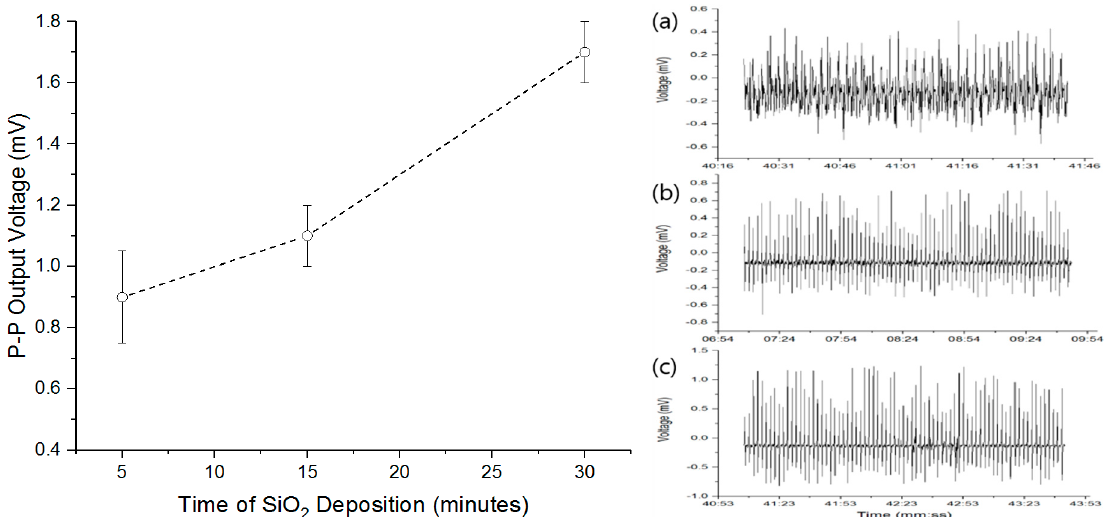
Figure 5. ( Left ) Peak to peak (P–P) output voltages of three SZS ‐ MGs as a function of the SiO 2 deposition time. (Average deposition rate of SiO 2 = 7.05 nm/min, ZnO = 4.55 nm/min at 200 W deposition power). ( Right ) Output voltage variations of the SZS ‐ MGs with SiO 2 thin films deposited for ( a ) 5 min, ( b ) 15 min, and ( c ) 30 min, respectively.